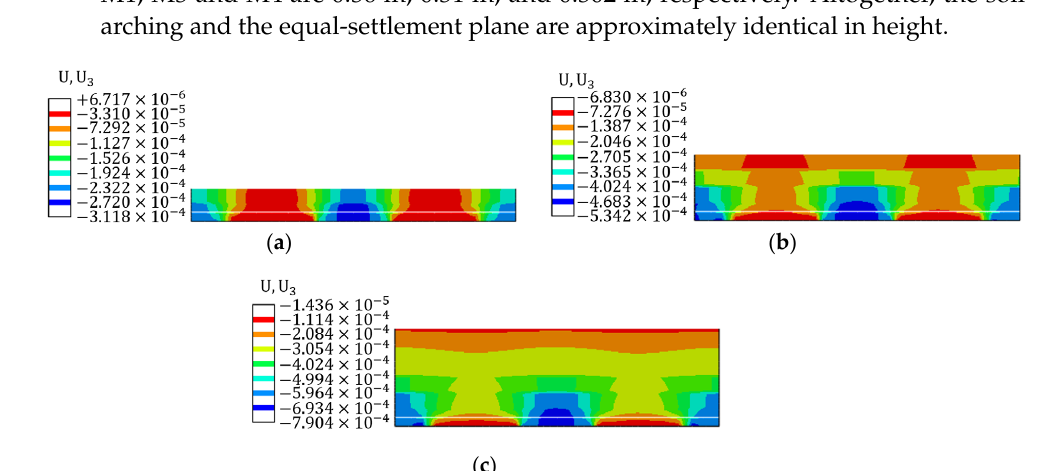
Figure 13. Vertical displacement distribution inside of embankment, ( a ) h = 50 mm; ( b ) h = 150 Figure 15. The curve of Vertical displacement in embankment, ( a ) result of M1; ( b ) result of M3; mm; ( c ) h = 250 mm. ( c ) result of